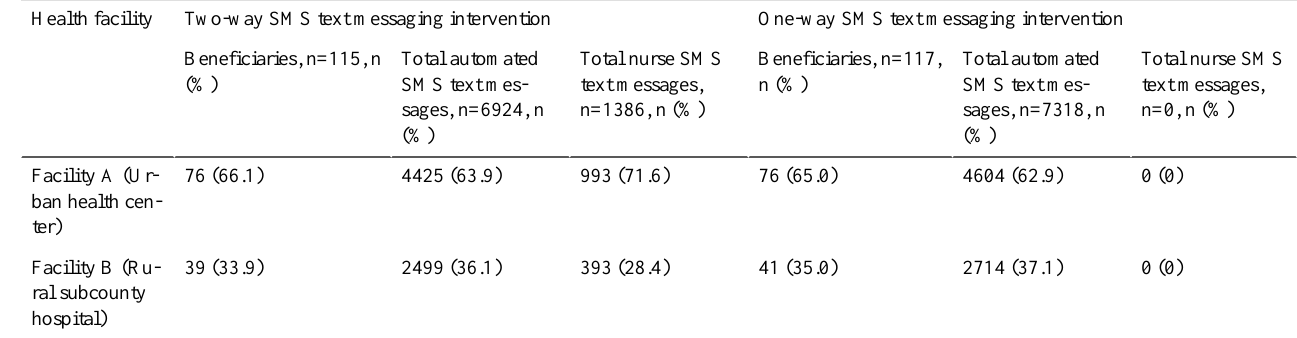
Table 2. Summary of the beneficiaries and the total points of contact by health facility in 2017.